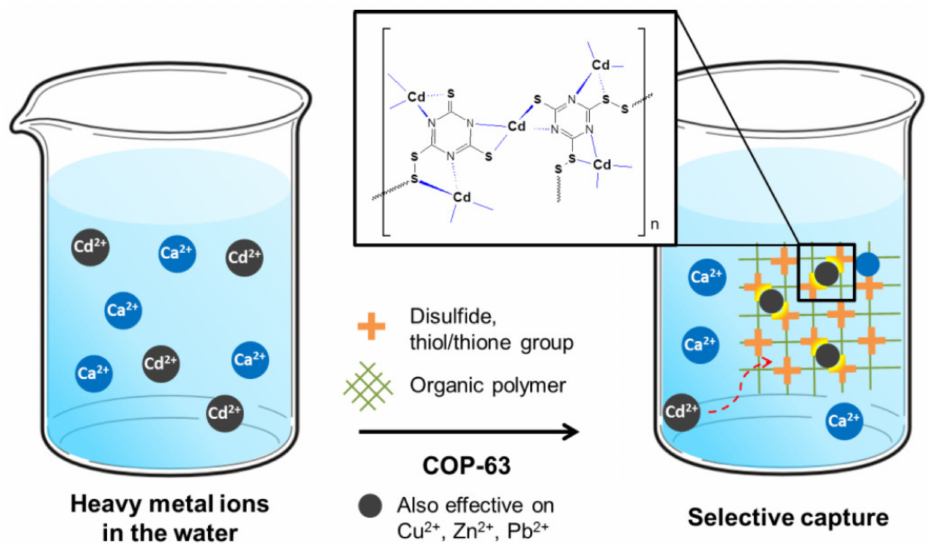
Figure 11. Selective interactions among heavy metal ions and sulphur groups in covalent organic polymer suspended in water. Reused with permission from